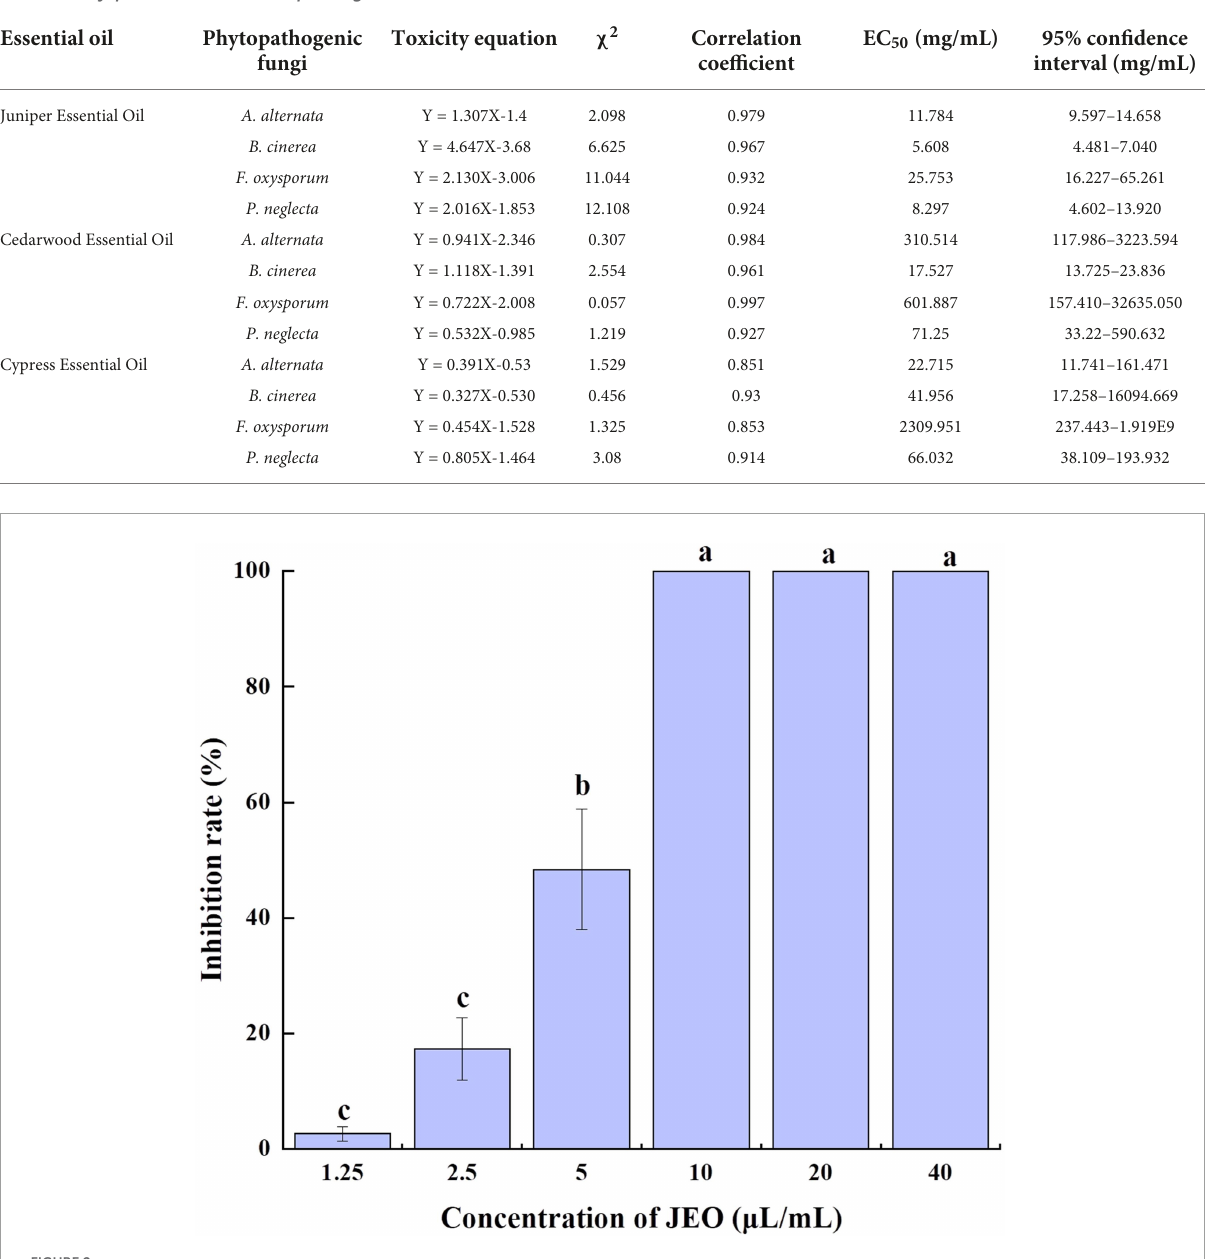
by a tendency to decrease within 12 h. The maximum